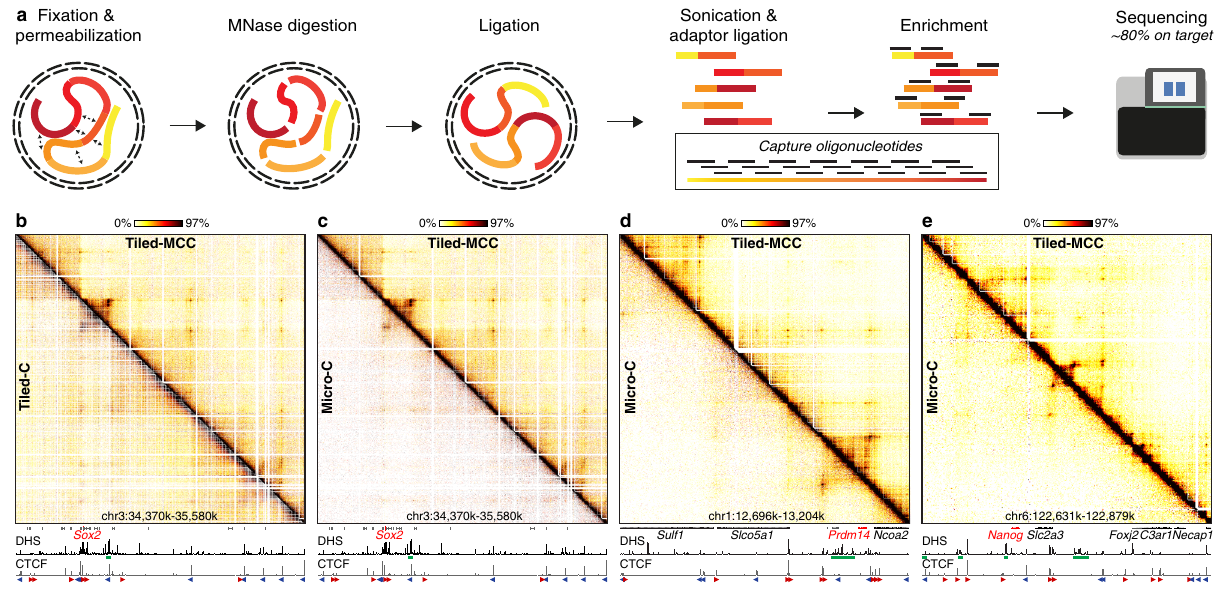
Fig. 1 Tiled-MCC generates local contact matrices with high sensitivity and resolution. a Overview of the Tiled-MCC procedure. Cells are initially crosslinked with formaldehyde and permeabilized with digitonin. The chromatin is subsequently digested with MNase, which is followed by proximity ligation. After DNA extraction, the MCC libraries are sonicated and ligated with indexed sequencing adaptors. Multiplexed libraries are subsequently enriched for regions of interest using panels of biotinylated capture oligonucleotides, which are optimized for hybridization to MNase-digested 3C libraries, and sequenced. b Comparison of Tiled-MCC (top-right) and Tiled-C (bottom-left) contact matrices at 500 bp resolution of the Sox2 locus in mES cells. c – e Comparison of Tiled-MCC (top-right) and Micro-C (bottom-left) contact matrices at 500 bp resolution of the Sox2 ( c ), Prdm14 ( d ), and Nanog ( e ) loci in mES cells. Gene annotation (genes of interest in red, coding genes in black, non-coding genes in gray), DNase hypersensitive sites (DHS), and ChIP-seq data for CTCF are shown below the matrices. The axes of the DHS and CTCF ChIP-seq pro fi les are scaled to signal and have the following ranges; DHS: Sox2 = 0 – 4.46, Prdm14 = 0 – 6.45, Nanog = 0 – 10.25; CTCF: Sox2 = 0 – 1833, Prdm14 = 0 – 2168, Nanog = 0 – 3092. Enhancers of interest are indicated in green below the DHS pro fi les. The orientations of CTCF motifs at prominent CTCF-binding sites are indicated by arrowheads (forward orientation in red; reverse orientation in